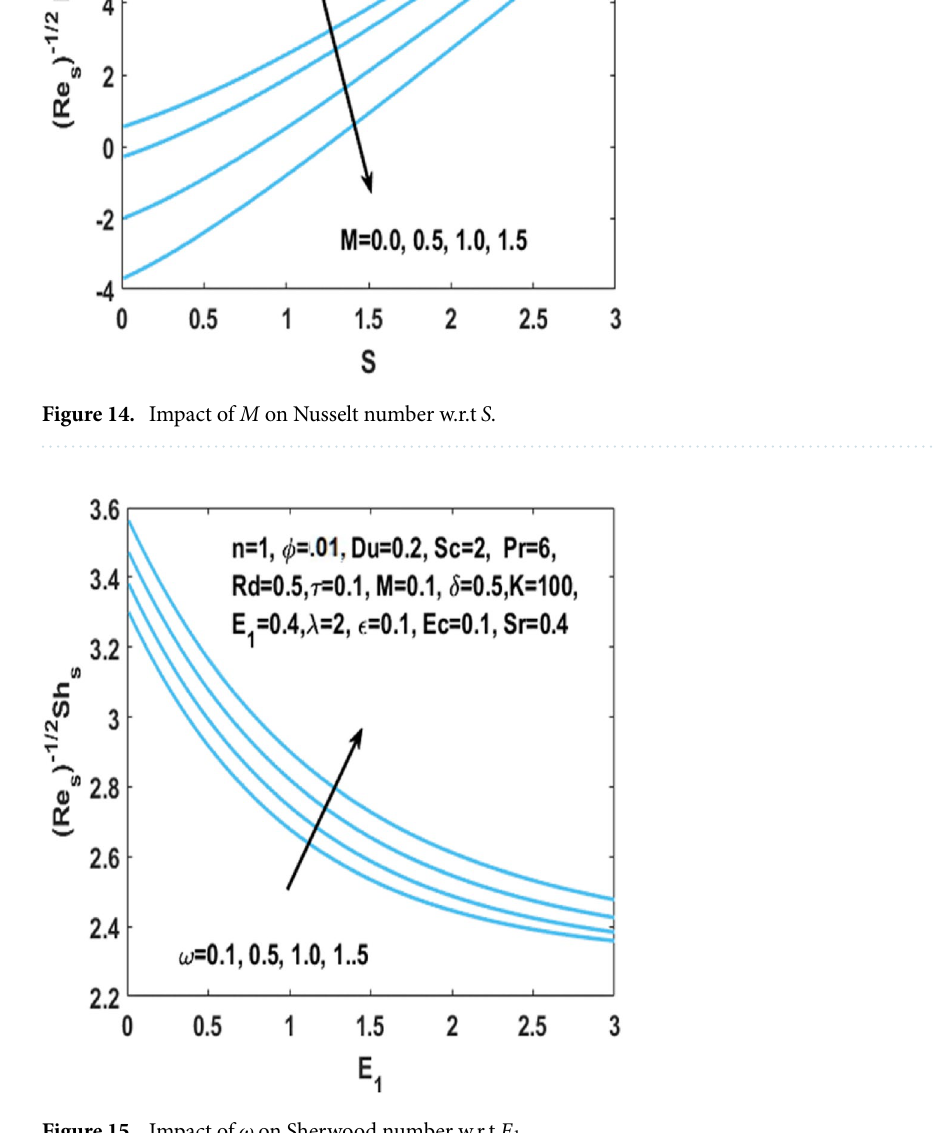
Figure 15. Impact of ω on Sherwood number w.r.t E 1